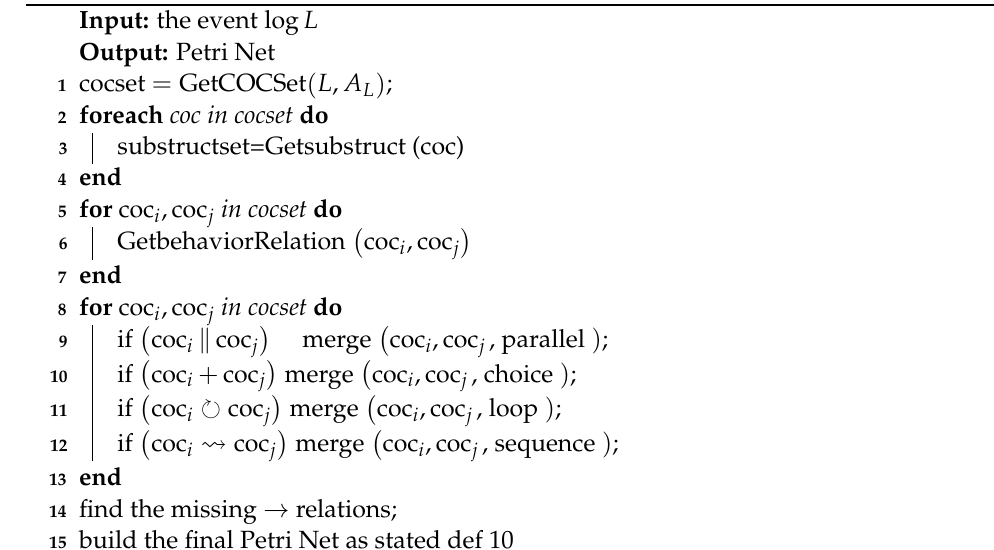
Algorithm 4: Construct Petri net from the event